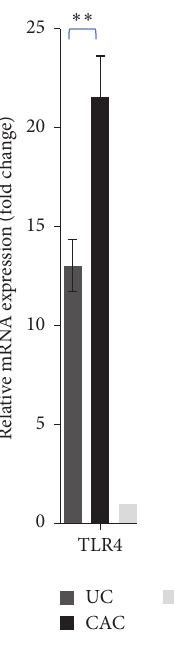
Figure 6: mRNA transcripts of TLR4 were quantitated in colonic mucosa of UC and CAC patients. Expression was normalized against 𝛽 -actin, HPRT, and GAPDH housekeeping gene, and rel- ative expression was represented data as fold differences by the 2 −ΔΔ Ct method, where Δ Ct = Ct target gene − Ct MG and ΔΔ Ct = Δ Ct inflamed colonic mucosa − Δ Ct normal colonic mucosa. Fold changes were calculated using the comparative Ct method. Data represent mean ± standard deviation. Significant difference between patients (UC/CAC) and controls is indicated ( 𝑃 < 0.001 ). Significant difference between 2 groups of patients (UC/CAC) is indicated ( ∗∗ 𝑃 < 0.01 ) (UC, ulcerative colitis, 𝑛 = 12 ; CAC, colitis associated cancer, 𝑛 = 5 ; C, control, 𝑛 = 5